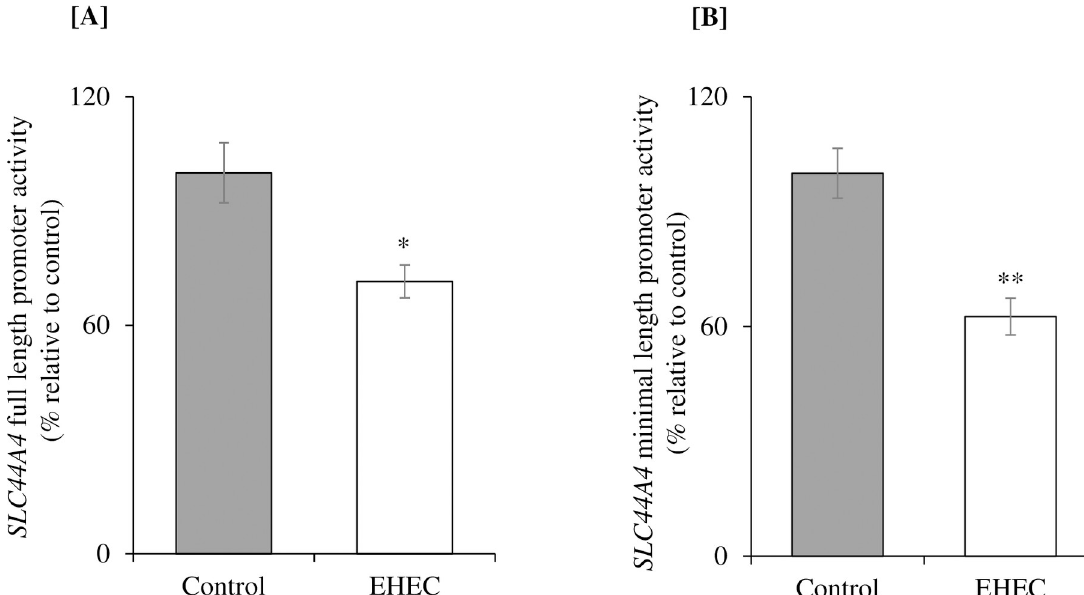
Fig 3. Effect of EHEC infection of NCM460 cells on activity of the SLC44A4 promoter. The relative promoter activity of human SLC44A4 full-length [A] and minimal promoter [B] constructs in pGL3 basic was examined in NCM460 cells infected with EHEC (200 MOI for 5 h) by luciferase assay. The relative values of promoter activity are expressed as fold change over pGL3 basic vector and data are presented as mean ± SE of 4 sets of independent experiments. �� P < 0.01; � P < 0.05.